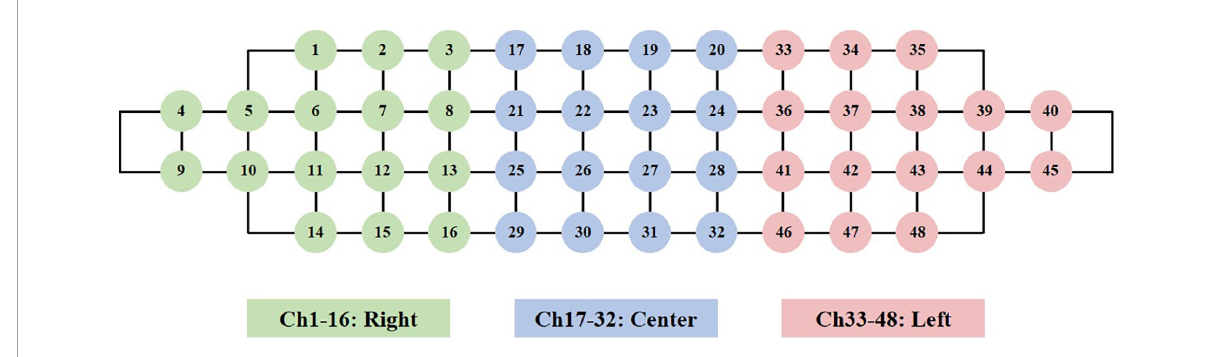
FIGURE2 Channel configuration in our experiment.